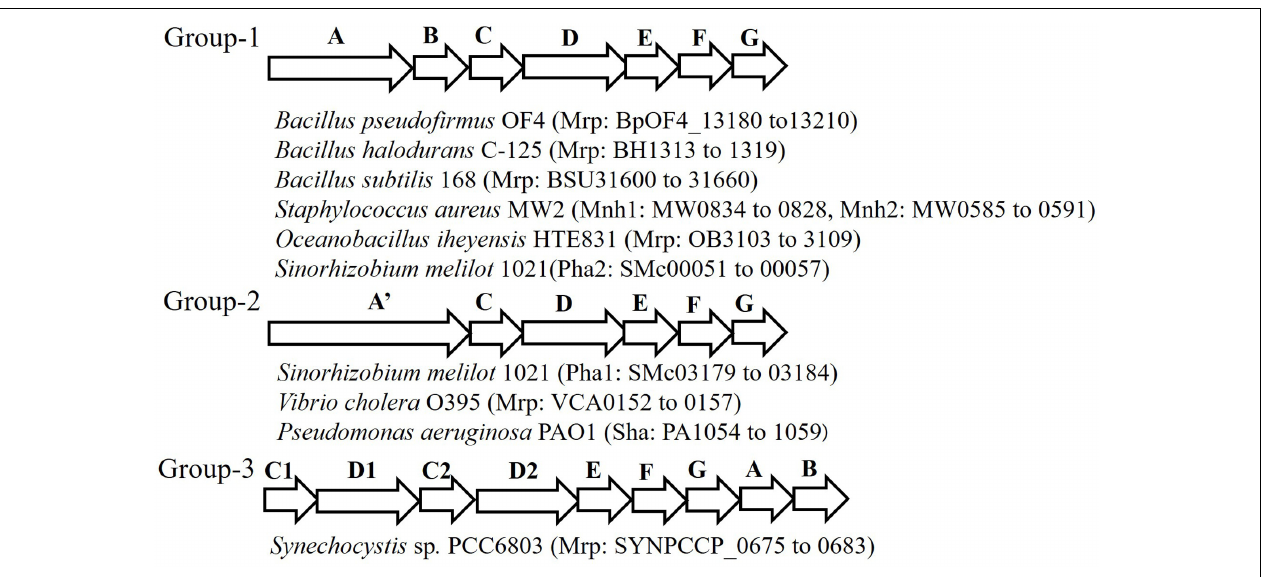
FIGURE 2 | Schematic of the diversity of the mrp gene cluster in several bacteria. This figure depicts the genetic structure of the mrp gene cluster of each bacterium. The locus tag numbers of each Mrp subunit gene are listed after the bacterial name. mrpA’ is a gene involving the fusion of mrpA and mrpB